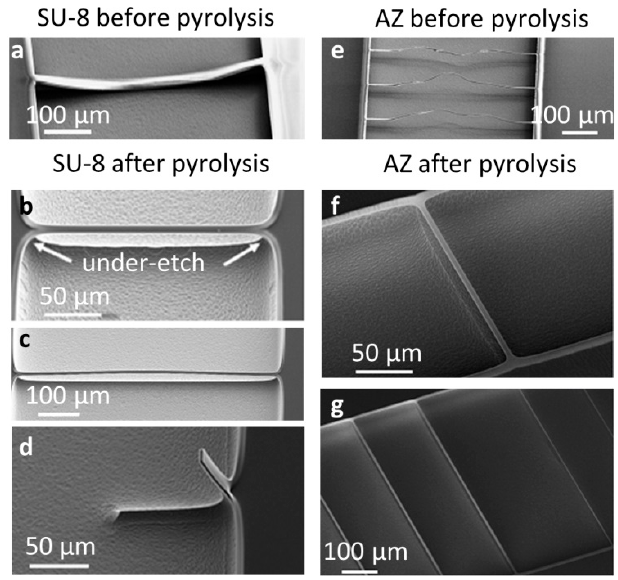
Figure 2. SEM pictures of the fabrication output of the “ dry etch-pyrolysis ” strategy. ( a ) SU-8 photoresist resonators ( L = 500 µm, w = 14 µm) collapsed after dry etch; ( b ) Suspended SU8-C ( L = 200 µm, w = 30 µm); and ( c ) ( L = 500 µm, w = 30 µm) resonators; ( d ) SU8-C cantilever ( L = 100 µm, w = 30 µm) with high initial bending; ( e ) AZ photoresist resonators ( L = 500 µm, w = 6 µm) with severely distorted structure due to high local temperature during dry etch; ( f ) Short AZ-C ( L = 200 µm, w = 14 µm); and long ( g ) ( L = 500 µm, w = 14 µm ( left ) and w = 6 µm ( right )) resonators. All dimensions are nominal mask dimensions.